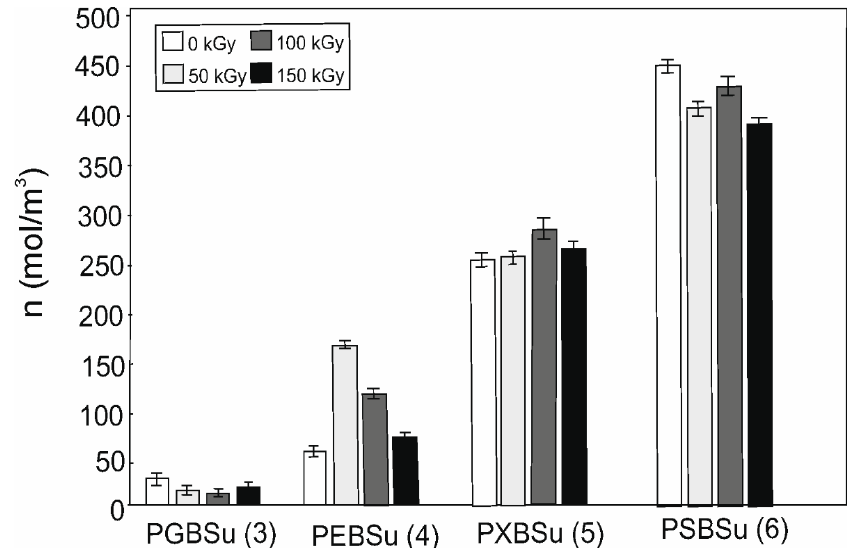
Figure 8. Cross-linking density of non-irradiated and radiation-modified PGBSu, PEBSu, PXBSu, and PSBSu. Hydroxyl group amount is indicated by the numbers in the brackets.